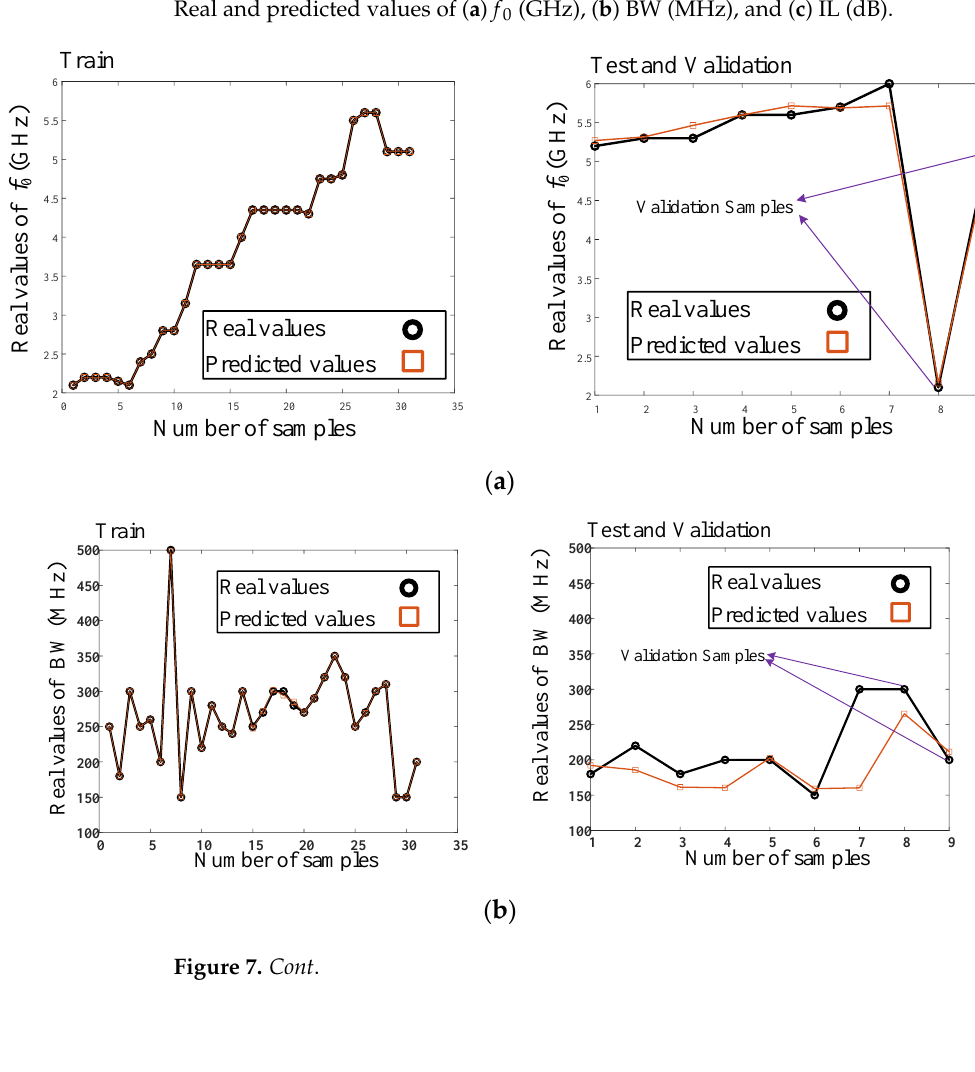
( c ) Figure 7. Real and predicted test and train values of ( a ) f 0 (GHz), ( b ) BW (MHz), and ( c ) IL (dB) parameters versus number of data samples in the proposed model. The real data of train, test, and validation procedures, using the proposed model, are listed in Table 1. The final results of the proposed ANN model are listed in Table 2, which show high accuracy of the prediction for the proposed model. The errors which are re- ported in this table correspond to the denormalized data. According to this table, the model is trained perfectly using the train data.